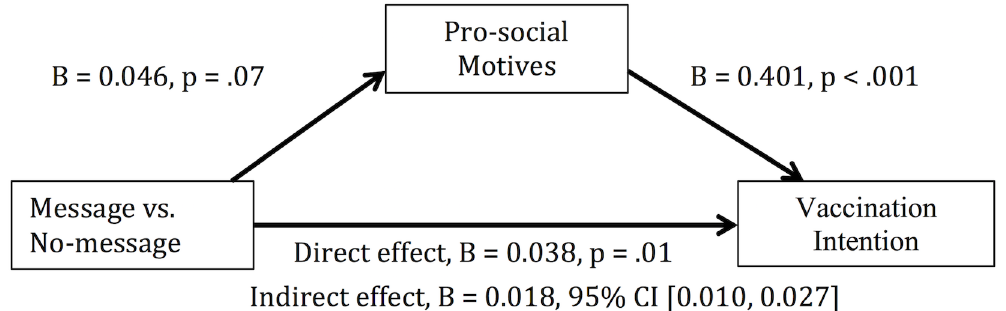
Fig 4. Mediational Model for the effect of message on vaccination intention among all participants, mediated by prosocial motives. This mediation was based on the bootstrapping method for calculating indirect effect developed by Hayes[32]. Participants included anyone with a valid response on vaccination intention (n = 3581). Analysis was performed in SPSS using the PROCESS macro developed by Hayes [ 32], with 5000 resampling to compute the Bias Corrected boot strapped 95% Confidence Intervals (BCa CI). Total effect of message on vaccination intention was significant, B = 0.056, BCa 95% CI [0.029, 0.083], p =